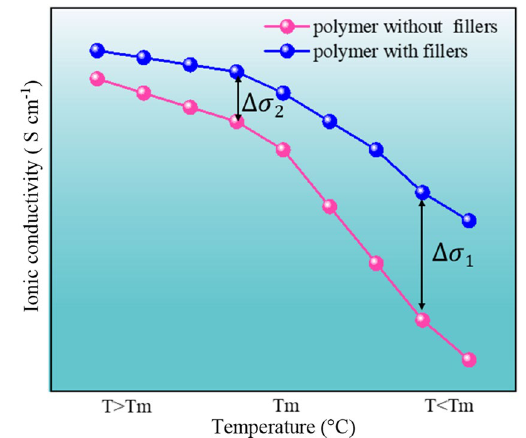
Fig. 18 Temperature dependence of ionic